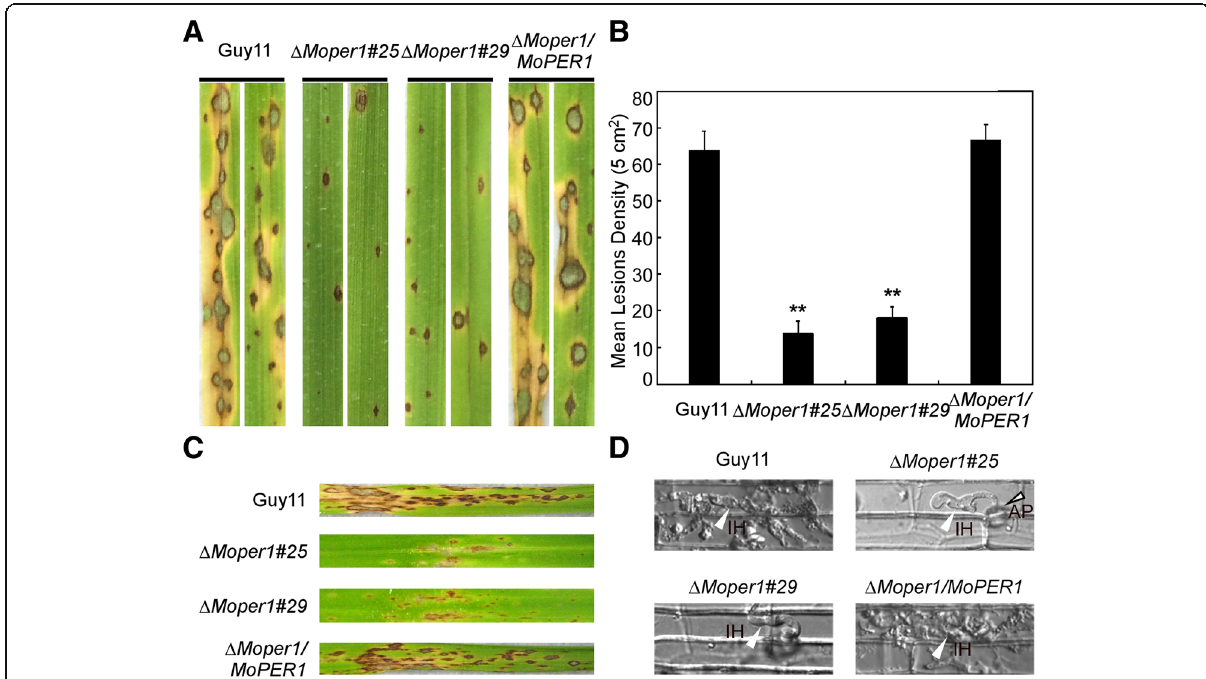
Fig. 6 pathogenicity assay of the mutant. a Leaf spraying assay. Four milliliters of conidia suspension (5 × 10 4 spores/ml) of each strain were sprayed on two-week old rice seedlings. Diseased leaves were photographed at 7 day after inoculation. b Lesion density was performed by counting lesion numbers of unit area. c Leaf injecting assay. Conidia suspension (5 × 10 4 spores/ml) of each strain were injected on two-week old